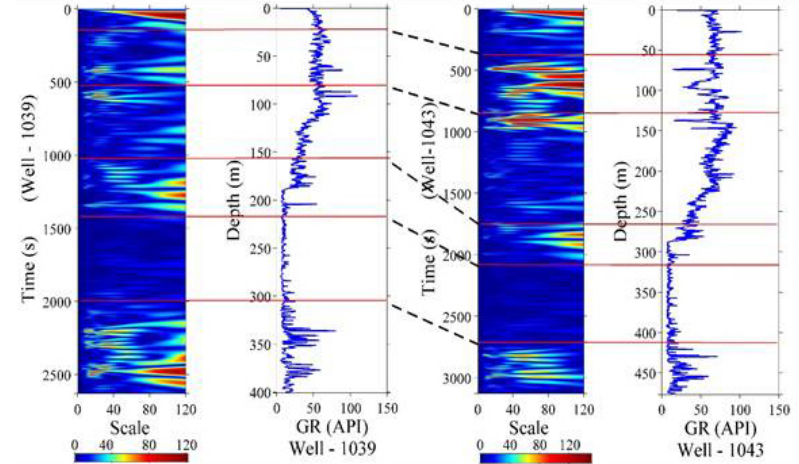
Figure 8. Lithology identification using the gamma ray log of well sites 1039 and 1043 by the lines drawn on the scalogram, and the subduction zone in the areas obtained from the seismic-migration section.